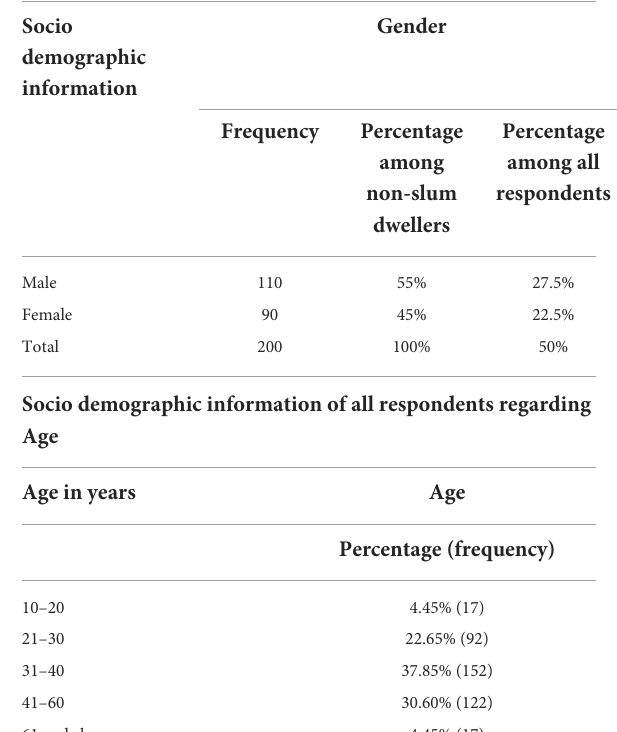
foul odors and is susceptible to insect infestation. Pit latrines are the simplest dry latrine to construct. They are just a hole excavated in the earth with a cover slab or floor over it (Figure 2B) To be deemed upgraded sanitation systems, pit latrines should include a cleanable cover slab. Hanging latrines in slums were traditionally made of corrugated metal